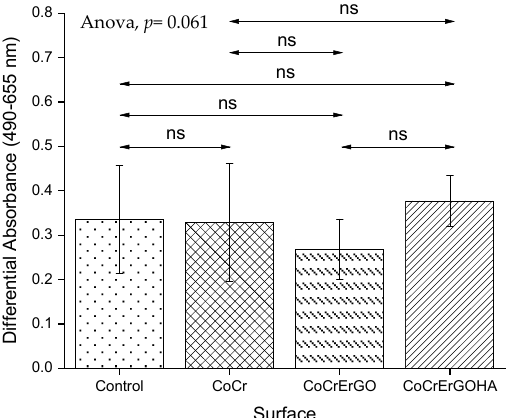
Figure 5. Effect of CoCr, CoCrErGO, and CoCrErGOHA on the LDH content in supernatants of osteoblast ‐ like MC3T3 ‐ E1 cell cultures. Osteoblasts were also cultured in the absence of any discs, and used as control. Differences between the studied samples did not reach statistical significance. ns: p > 0.05.